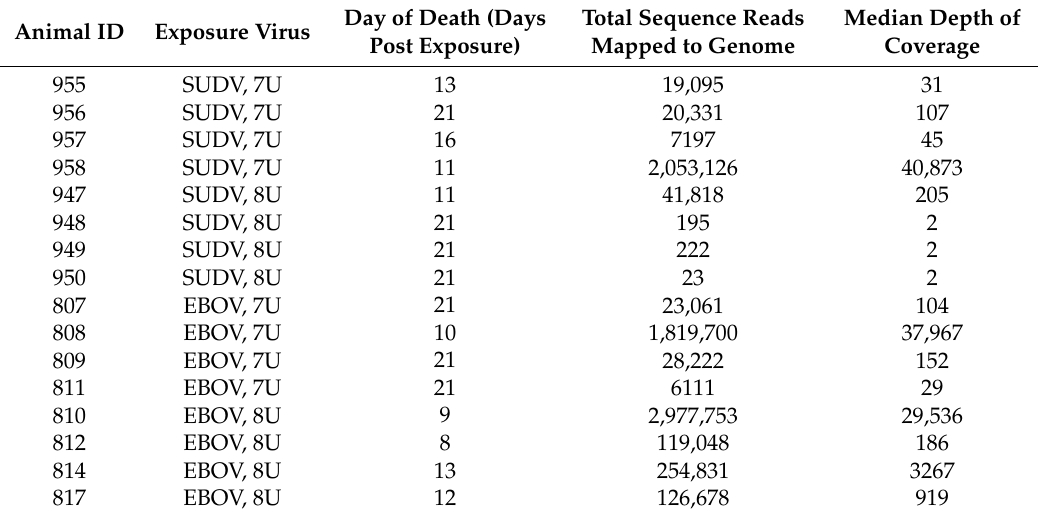
Table 3. Deep sequencing of RNA extracted from the serum at (or near*) time of death: Sequence reads mapped to the SUDV or EBOV